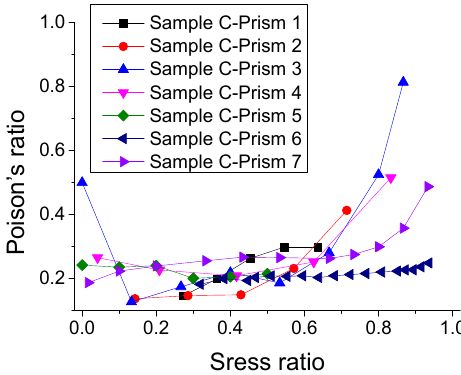
Figure 16. Experimental results of relationship of Poisson’s ratio–stress ratio ( υ v.s. σ / f c ).